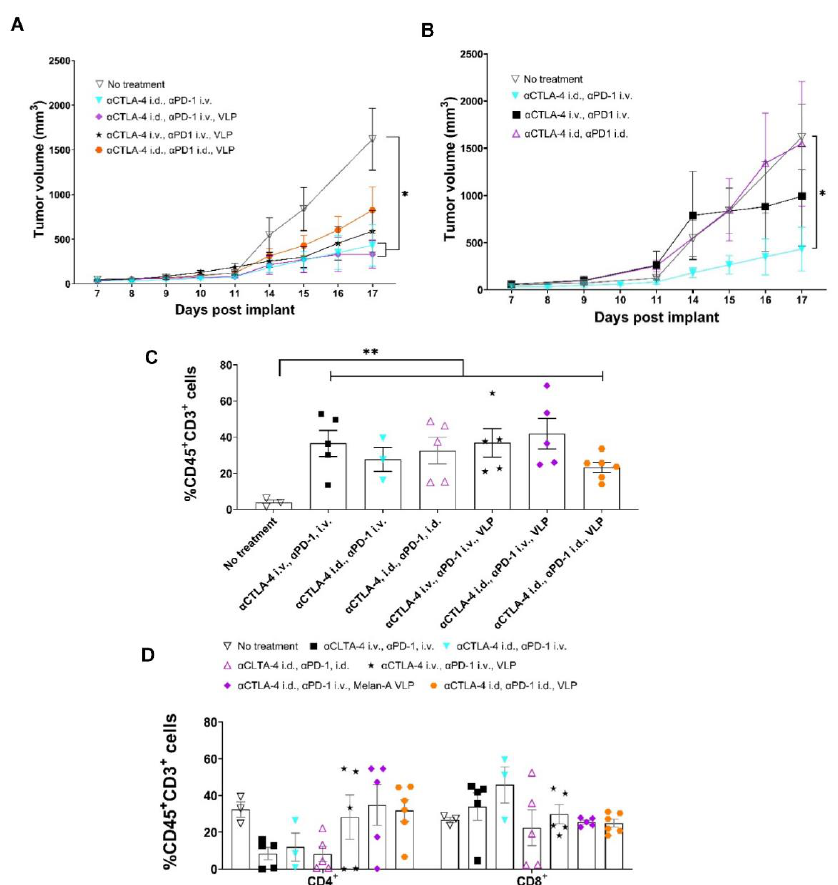
Figure 7. Response to lymphatic and systemic combination treatment in vaccinated animals. ( A ) Lymphatic delivery of α CTLA-4 and Melan-A VLP in combination with α PD-1 further decreases primary tumor growth. No treatment ( ▽ , n = 5); α CTLA-4 i.d., α PD-1 i.v., ( ▼ , blue, n = 5); α CTLA-4 i.v., α PD-1 i.v., Melan-A VLP ( ★ , n = 10); α CTLA-4 i.d., α PD-1 i.v., Melan-A VLP ( ◆ , purple, n = 10); and α CTLA-4 i.d., α PD-1 i.d., Melan-A VLP ( ⬣ , orange n = 15). ( B ) Systemic delivery of α PD-1 in unvaccinated animals dosed with α CTLA-4 further decreases primary tumor growth. Non-treatment ( ▽ , n = 5); α CTLA-4 i.d., α PD-1 i.v., ( ▼ , blue n = 5); α CTLA-4 i.v., α PD-1 i.v., ( ■ , n = 10); and α CTLA-4 i.d., α PD-1 i.d., ( △ , pink, n = 15). ( C ) Lymphatic delivery of α CTLA-4 in combination with α PD-1 increases CD45 + CD3 + T-cells in the tumor microenvironment. ( D ) Lymphatic delivery of α CTLA-4 in combination with α PD-1 in vaccinated animals changes the distribution of CD4 + and CD8 + in the tumor microenvironment. Non-treatment ( ▽ , n = 3); α CTLA-4 i.v., α PD-1 i.v., ( ■ , n = 5); α CTLA-4 i.d., α PD-1 i.v., ( ▼ , blue, n = 3); α CTLA-4 i.d., α PD-1 i.d., ( △ , pink, n = 5).; α CTLA-4 i.v., α PD-1 i.v., Melan-A VLP ( ★ , n = 5); α CTLA-4 i.d., α PD-1 i.v., Melan-A VLP ( ◆ , purple, n = 5); α CTLA-4 i.d., α PD-1 i.d., Melan-A VLP ( ⬣ , orange n = 6). *, ** Denotes statistical significance by unpaired, two-tailed Student’s t test ( p < 0.05, 0.005). Error bars indicate SEM. i.d., intradermal; i.v., intravenous.